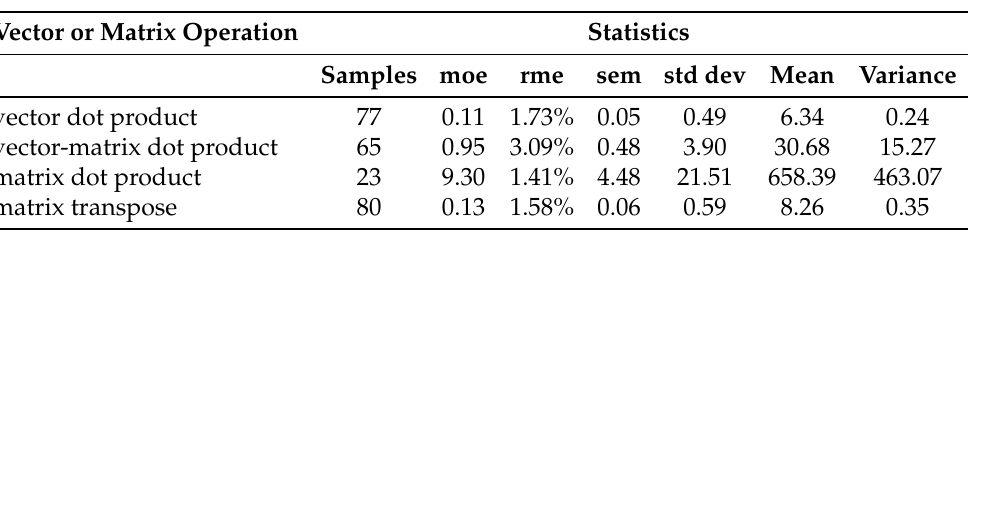
Table 14. Raspberry Pi III B+ benchmark statistics for vector and matrix operations with k = 32 (times in